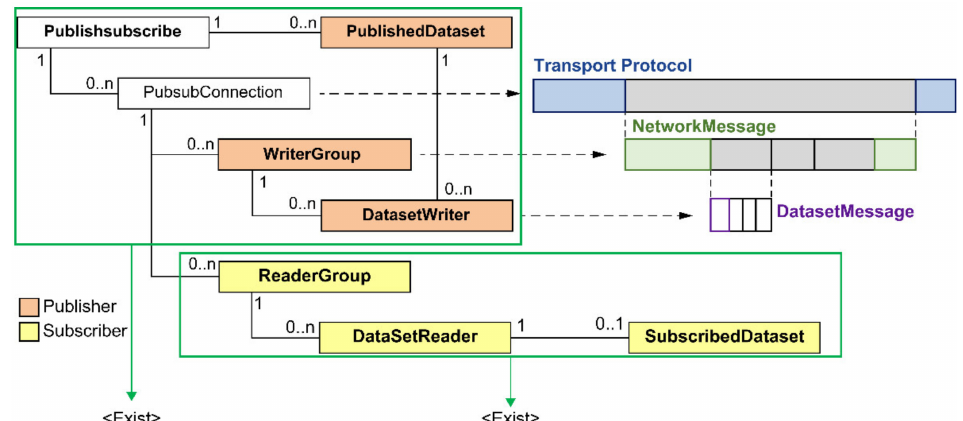
Figure 6. A-Open62541 PubSub UML diagram.